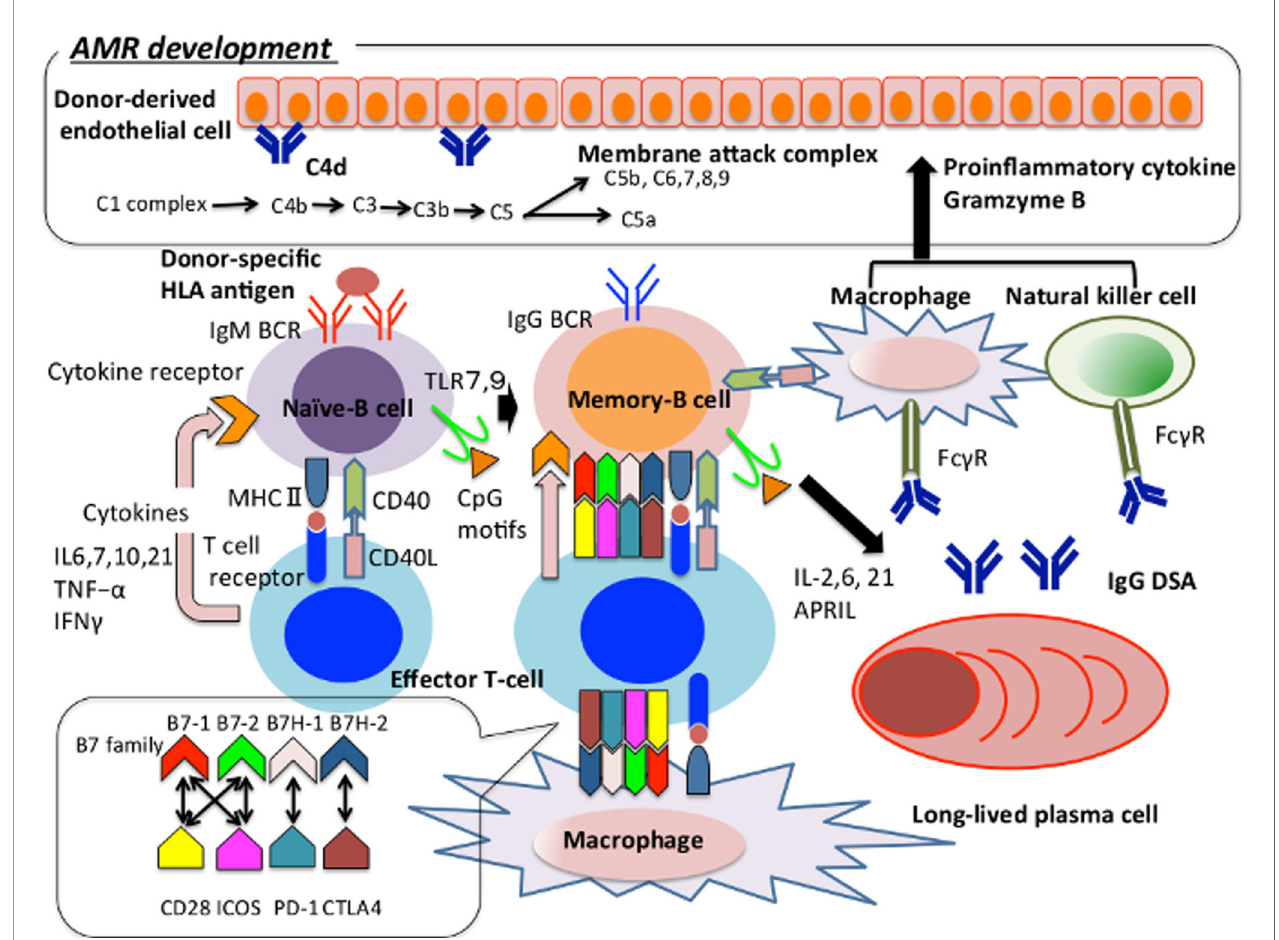
FIGURE 1 | The pathway of naïve-B cell differentiation into plasma cell in the context of AMR development. We show how immunocompetent cells are involved in the onset of AMR, focusing on B cells. Naïve-B cell recognises donor-speci fi c HLA antigen and present the antigen peptides from MHCII to T cell receptor and activate T cells. The activated T cells regulate the growth and survival of B cells through the production of IL4, 6, 7, 10, 21, TNF- a , IFN g , etc (46). Activated B cell migrates to secondary lymphoid tissue, class-switches to IgG and then undergoes gene conversion and hypersomatic mutation in the germinal center to have a high af fi nity for donor-speci fi c HLA antigen. These cells migrate into the bone marrow and differentiate into long-lived plasma cells, and keep producing IgG DSAs for a long term. Furthermore, TLR 7/9 is expressed on the surface of naïve-B cells. TLR7 plays an important role in T cell activation and germinal center B-cell development (24). TLR9 recognizes the CpG motif and supports the survival and proliferation of B cells through IL-6 production and T cell activation (47). T cells regulate B cells ’ activation and sustain the interaction between follicular helper T cells and germinal center B cells through the association between the B7 family and CD28, ICOS, PD-1, CTLA-4 expressed by B cells, and CD 40 ligand and CD40 expressed by B cells. Regarding macrophages and natural killer cells function as antigen-presenting cells and induce B cells and T cells activation. IgG-type DSA binds to Fc g on the macrophages and natural killer cells ’ surface and activates them. Complement activates adaptive immunity against thymus dependent antigen, or it activates the membrane attack complex and induces in fl ammation and tissue damage on vascular endothelial cells, thereby supporting the onset of AMR. AMR, Antibody-mediated allograft rejection; APRIL, A proliferation-inducing ligand; BCR, B cell receptor; CD40L, CD40 ligand; CTLA-4, Cytotoxic T-lymphocyte associated antigen 4; DSA, Donor-speci fi c HLA antibody; Fc g R, Fc gamma receptor; IFN, Interferon; ICOS, Inducible T-cell co- stimulator; MHC, Major histocompatibility complex; PD-1, Programmed cell death – 1; TNF, Tumor Necrosis Factor; TLR, Tool-like